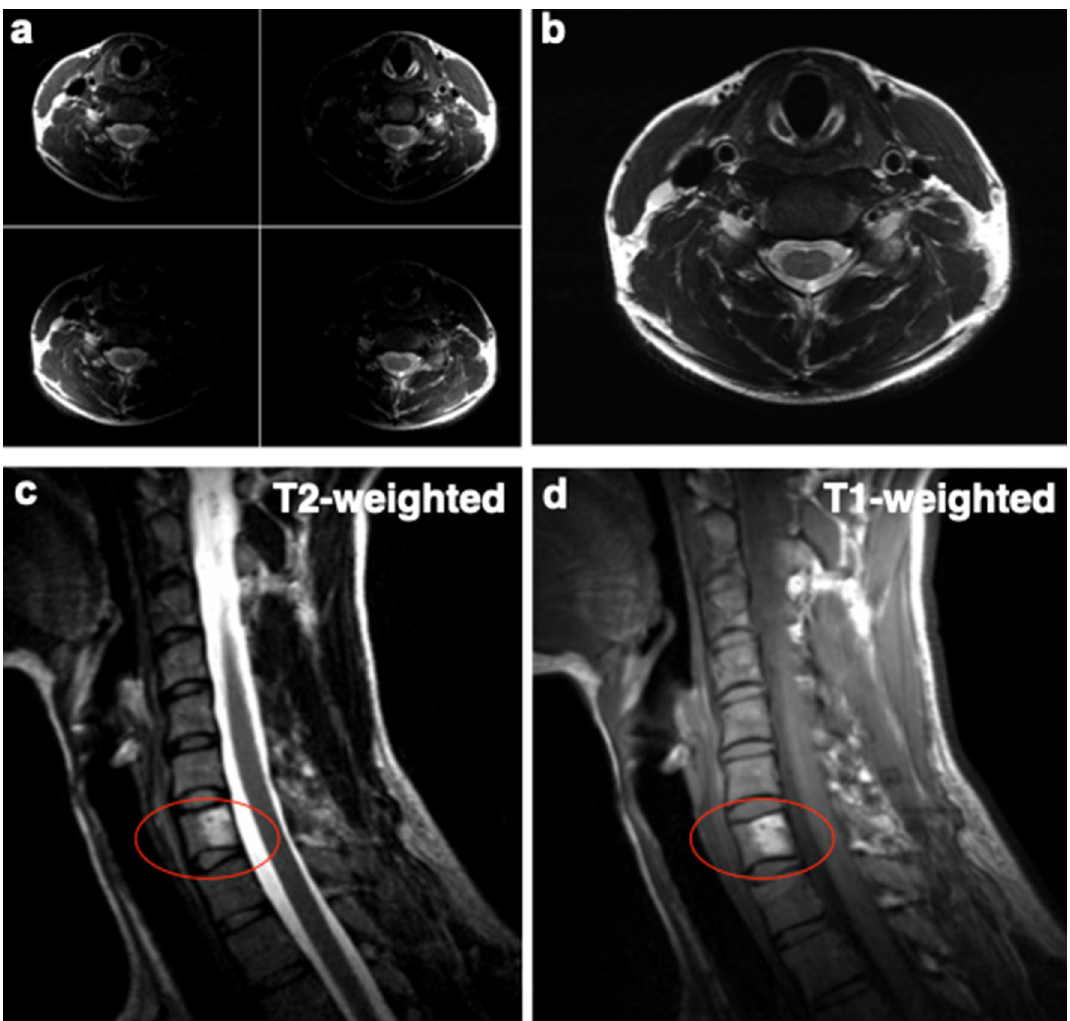
Figure 4. Imaging of the body parts relevant for clinical applications. ( a ) Images of the neck cross-section taken by individual elements. ( b ) Combined image of the neck cross-section. T2 ( c ) and T1 ( d ) weighted sagittal images of the spine of the volunteer with vertebral hemangioma (indicated with red